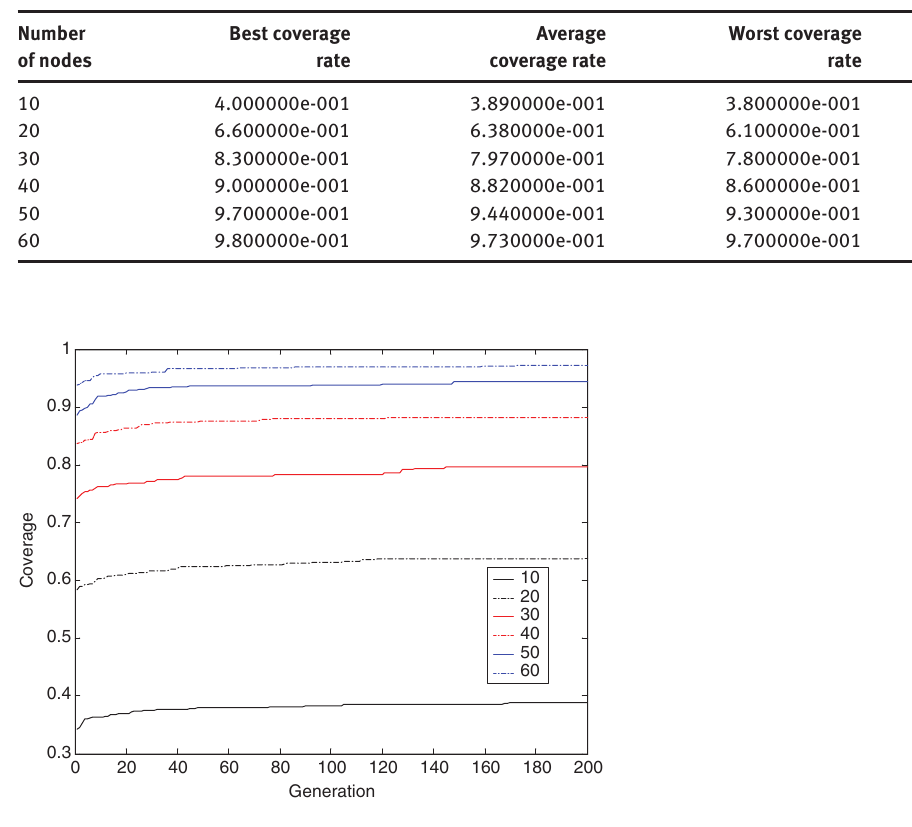
Figure 15: The Coverage Rate Curves When the Number of Nodes Was Set in Different